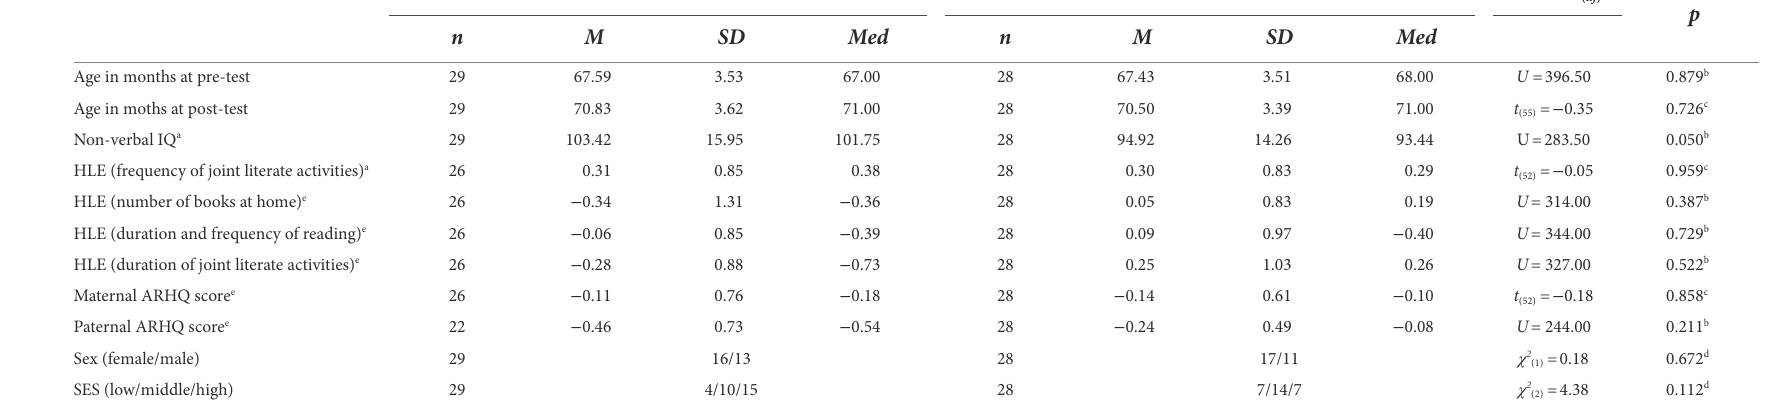
TABLE 1 Demographic characteristics of the typically developing and at-risk passive control